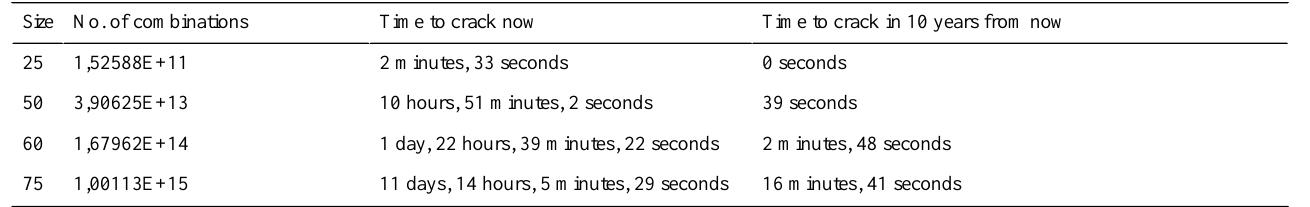
Table 1. Number of combinations of passwords of length up to 7 and maximum time to crack them now and in 10 years.